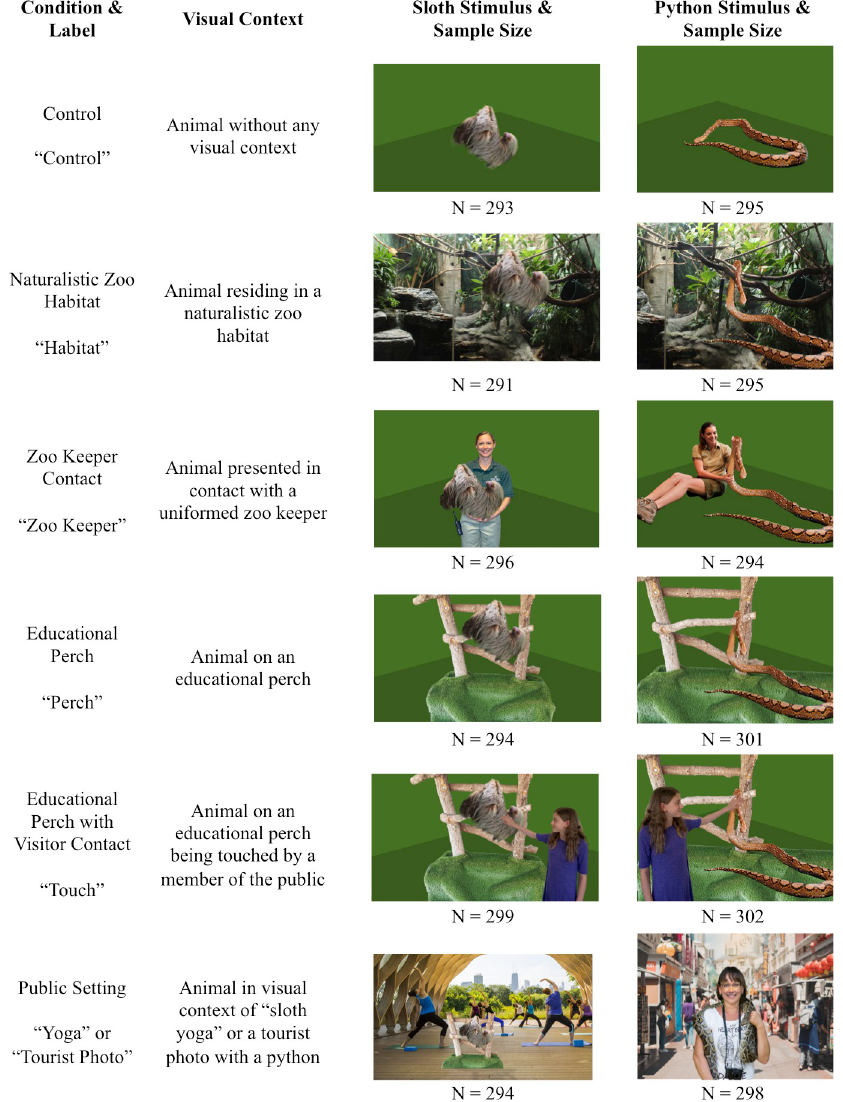
Fig 1. Experimental conditions, visual stimuli, and sample size per condition. Conditions presented in the online survey in a between-participants design, and number of subjects in each condition. An additional condition was run for internal evaluation of a Lincoln Park Zoo program; details are in Supporting